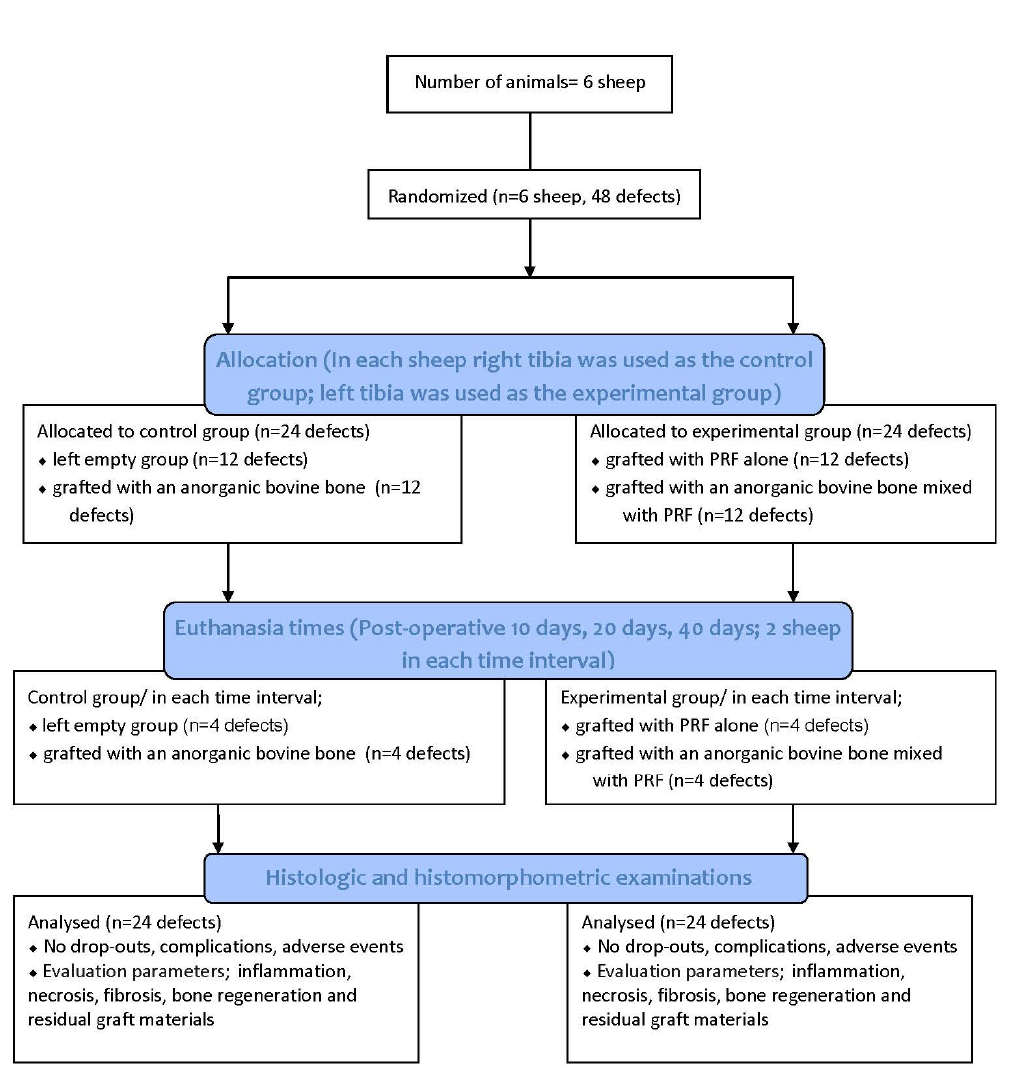
Figure 1. Flow diagram of the study. PRF: Platelet Rich